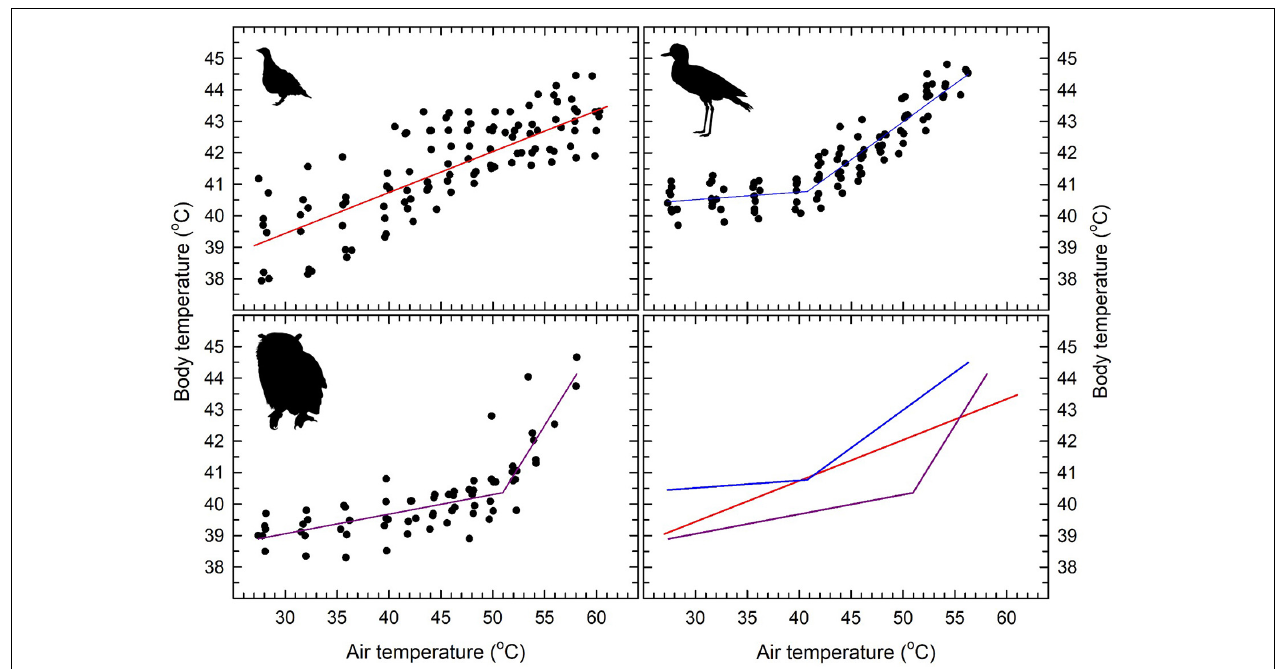
FIGURE 1 | Relationships between body temperature ( T b ) and air temperature ( T air ) in three species from the southern African arid zone: Namaqua sandgrouse ( Pterocles namaqua ; top left), spotted thick-knees ( Burhinus capensis ; top right) and spotted eagle-owls ( Bubo africanus ; lower left). The solid lines show a linear regression model (sandgrouse) or segmented linear regression model (thick-knees and owls). Inflection T air values and slopes for relationships between T b and T air are provided in Table 2 . The lower right panel shows the regression models for all three species for comparative purposes. The bird silhouettes were obtained from http://phylopic.org: Pterocles (Tarique Sani, John E. McCormack, Michael G. Harvey, Brant C. Faircloth, Nicholas G. Crawford, Travis C. Glenn, Robb T. Brumfield and T. Michael Keesey), Burhinus (Auckland Museum) and Bubo (Lukasiniho). They are reproduced here under Creative Commons Licences (sandgrouse and thick-knee: https://creativecommons.org/licenses/by/3.0/; owl: